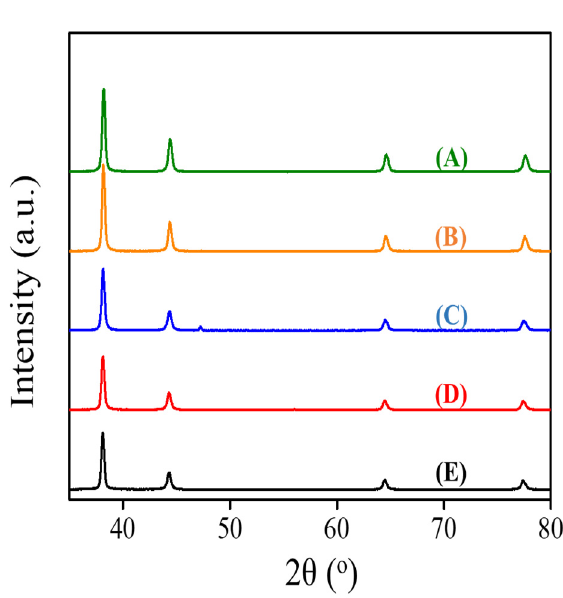
Figure A1. XRD data of various Au@Ag-DNFs/Si samples.